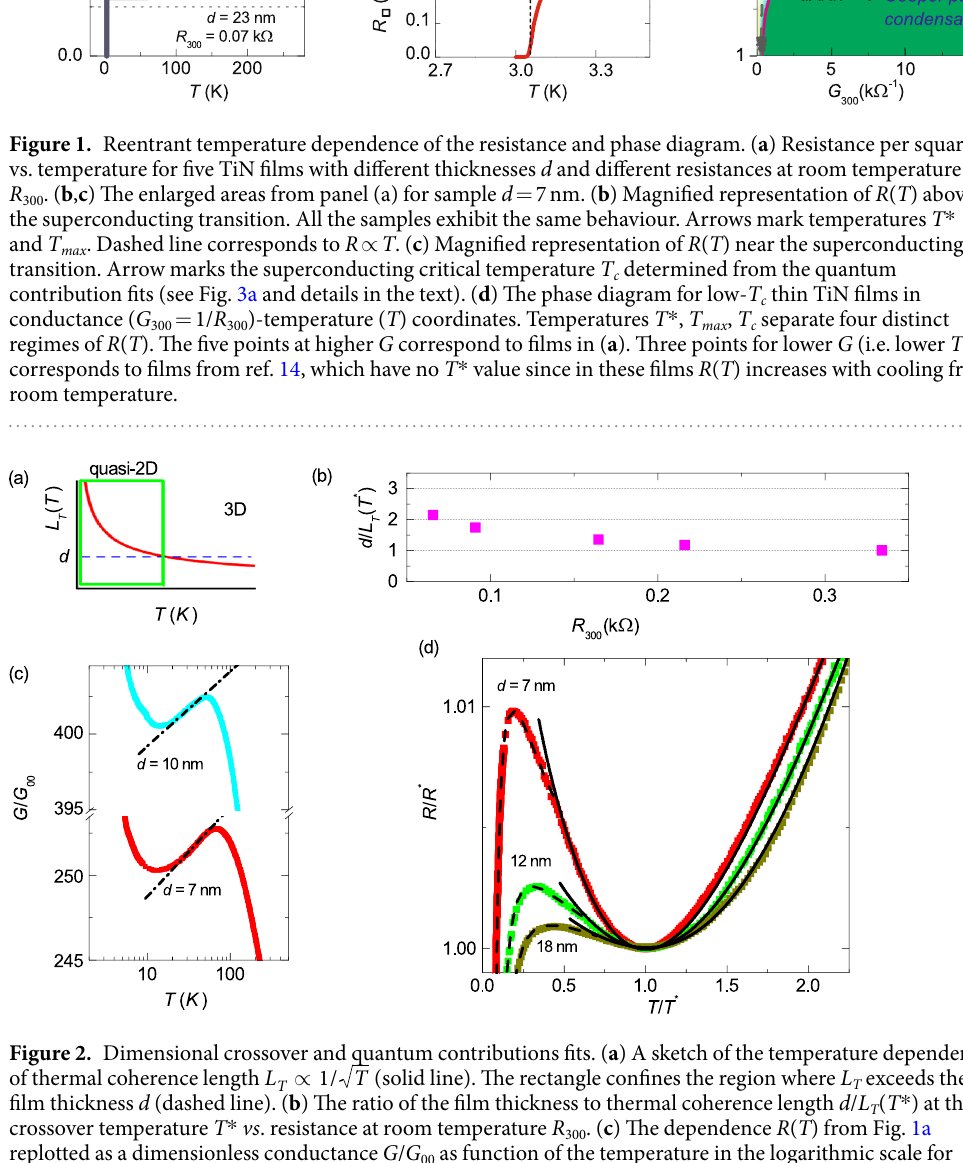
analyzed in refs 13, 14. Here we deal with homogeneously disordered films i.e. films with < istic size of structural inhomogeneities δ x less than characteristic lengths of the system. In this case the most reliable measure of disorder is the resistance per square  R (in other words the conductance G ) of the system 15 .